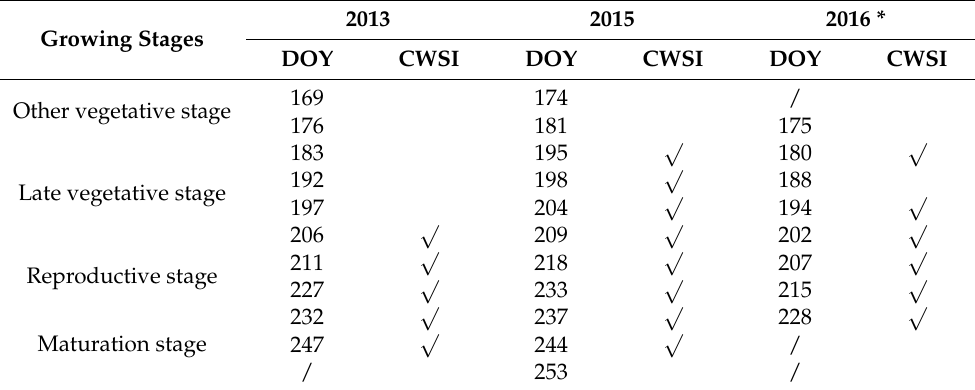
Table 2. Red-Green-Blue (RGB) images and crop water stress index (CWSI) data measurements with √ respect to the day of year (DOY). ” ” represents that there are corresponding CWSI data.